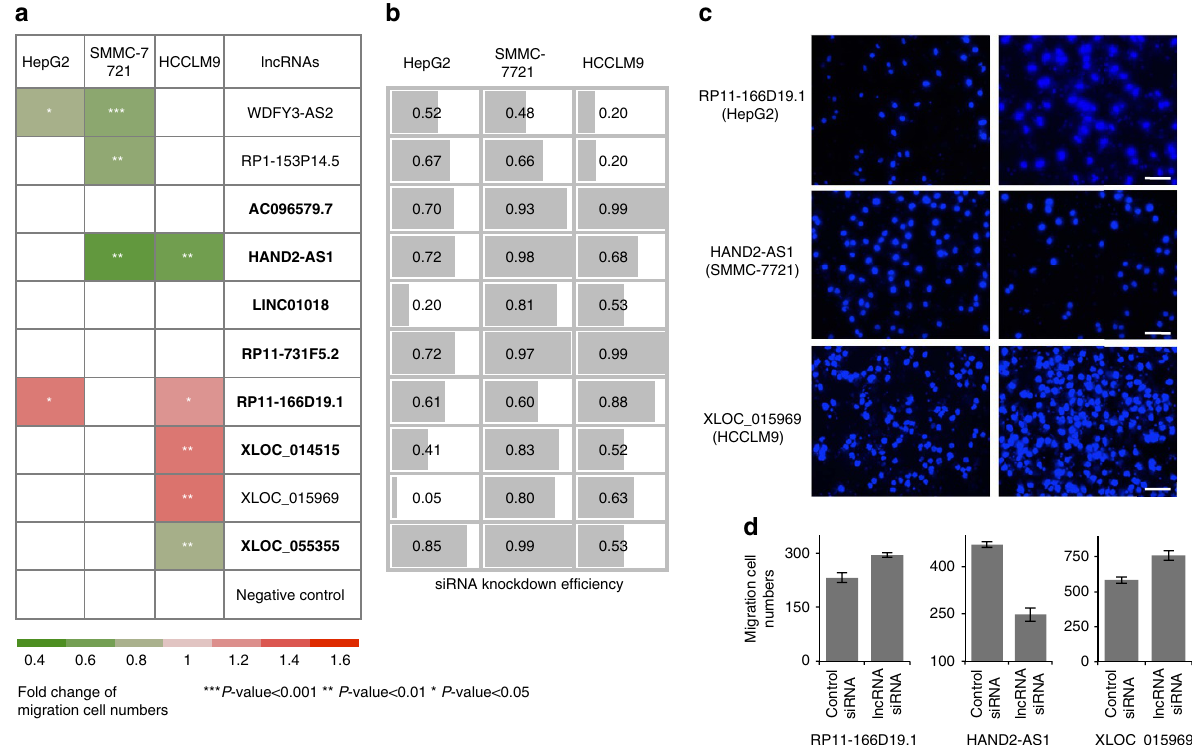
Figure 6 | Loss-of-function assay of candidate lncRNAs regulating cell migration. Transwell migration assays were conducted to test the effects of siRNA-mediated RNAi of candidate lncRNAs in three liver cancer cell lines: HepG2, SMMC-7721 and HCCLM9. ( a ) The value in the heatmap is the fold-change ( P value o 0.05) of the transwell cell numbers for knockdown cells over those of control cells. All results are expressed as the mean derived from three independent experiments. The unpaired Student’s t -test (two-tailed) was used for comparisons of two groups. Seven of the ten candidate lncRNAs were metastasis-associated lncRNAs that were recurrently deregulated in PVTTs (in bold font). * P value o 0.05, ** P value o 0.01, *** P value o 0.001, t -test, n ¼ 3. ( b ) RNAi was validated by qRT-PCR. Examples of migration phenotype: transwell cells (DAPI staining) ( c ) (Scale bar, 500 m m) and their counts ( d ). Error bars represent the s.d. of three experiment